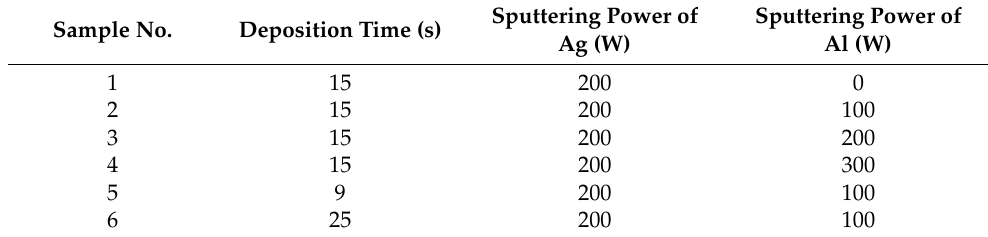
Table 1. Process parameters for each sample.